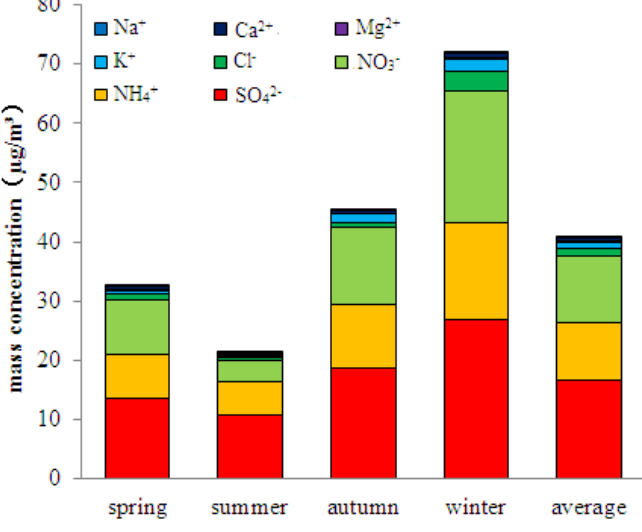
Figure 3. Seasonal variation of water-soluble ions in Wuhan during the observation period.